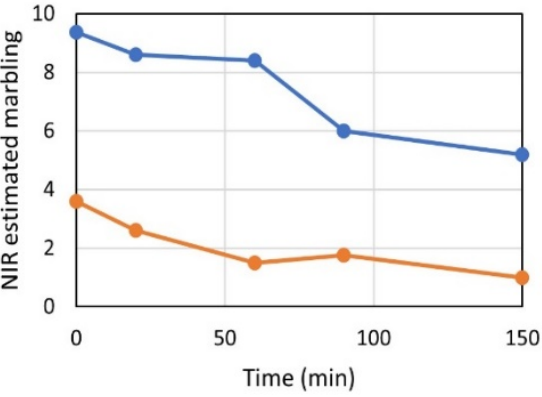
Figure 7. NIR estimated marbling scores over time for fat (blue) and lean (orange) loin